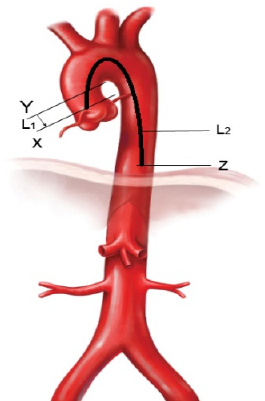
Figure 1. Schematical representation of the references used in the calculation of PWV (X—aortic valve level; Y—ascending aorta, 2 cm above the valve; Z—diaphragm level; L1 = distance from X to Y (2 cm), L2 = distance from X to Z (from the aortic valve to the diaphragm) = 1.7 cm + 0.1 × height (cm). PWV (ascending aorta) = L1/ Δ T1, PWV (descending aorta) = L2/ Δ T2.